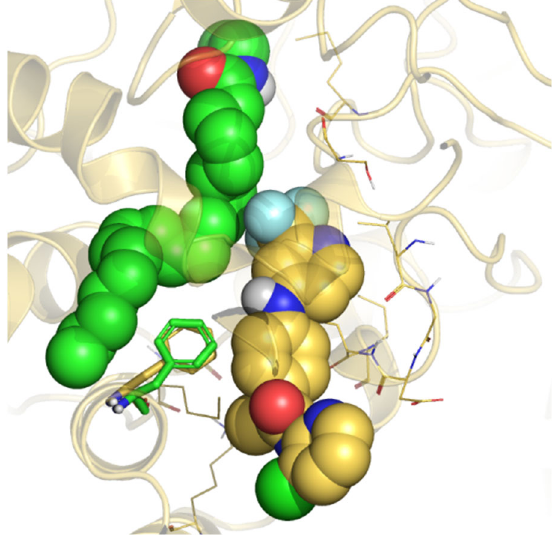
Figure 4. Representation of the 50 ns MD last frame of r FAAH in complex with AEA and the B3db1 binding mode of TPA14. AEA and the B3db1 binding of TPA14 are represented as green and gold spheres, respectively. F432 is represented as a green and gold stick for the AEA and TPA14 B3db1 binding simulation, respectively.